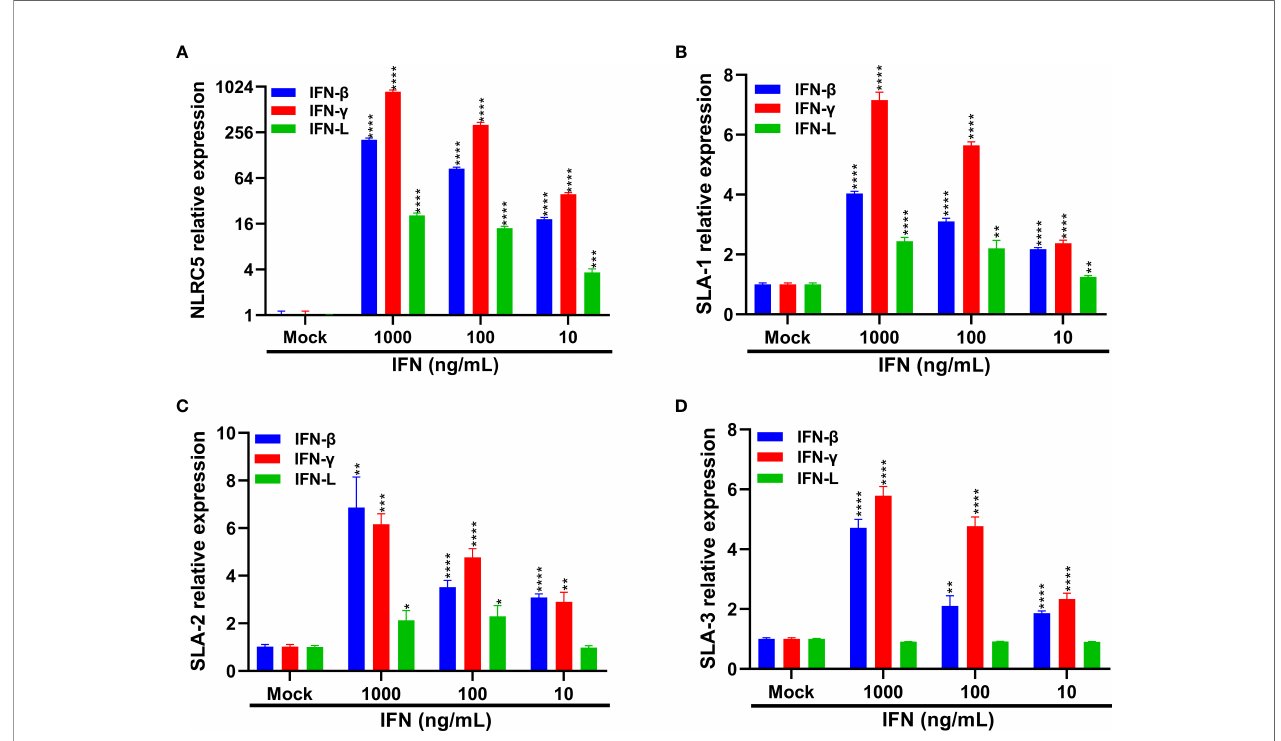
FIGURE 10 | IFNs treatment increases the expression of SLA-I and its associatedantigen-presentation genes. (A – D) IPEC-J2cellswere respectively pretreated with IFN- b , IFN- g , and IFN-L at the indicated concentrations for 24 h.The expression levelsof NLRC5 (A) , SLA-1 (B) , SLA-2 (C) , and SLA-3 (D) were examined byRT-qPCR.Data are presentedas themeans± SEMs (n = 3).The scaledata of panel (A) were taken as log 2 (fold change) values. The differences between groups were compared using the Student ’ s t test. Error barsdenote the deviations, and the p values are expressed as follows: * p < 0.05, ** p < 0.01, *** p < 0.001, and **** p <